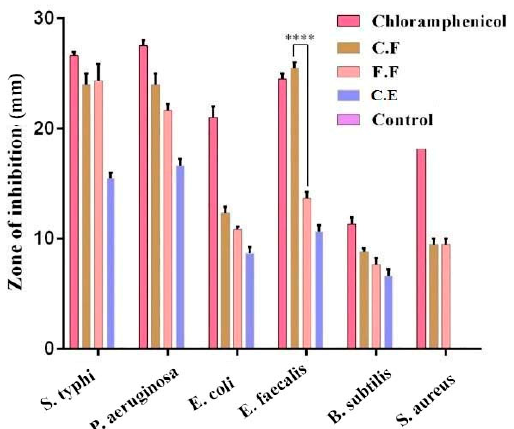
Figure 1. Antimicrobial activity (zone of inhibition; 500 µ g / disc) of free (FF) and conjugated flavonoids (CF) and crude extracts (CE) against Gram-negative and Gram-positive bacteria. **** p ≤ 0.0001.